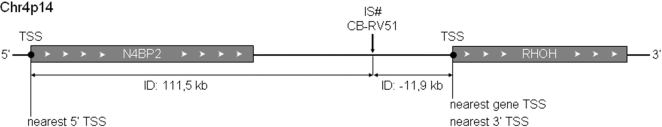
Example of integration distance calculation for one integration site mapped on Chromosome 4 (CB-RV51 insertion site in [20] dataset).Notice that in this particular case the transcription start site (TSS) of the nearest gene coincides with the nearest downstream (3′) TSS.